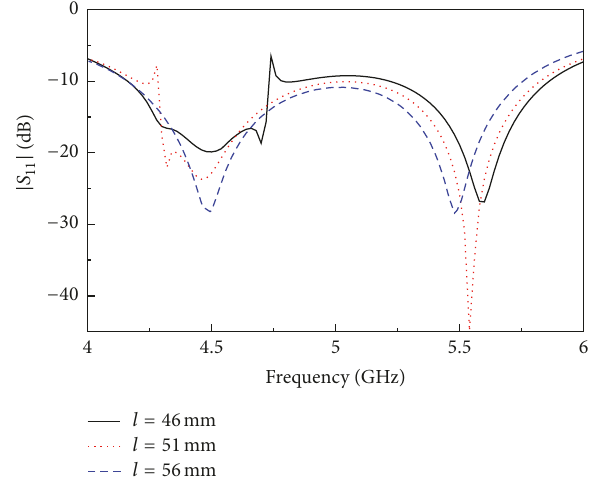
Figure 7: Simulated reflection coefficients of antenna III as a function of frequency for different cell lengths of 𝑙 = 46 , 51 and 56